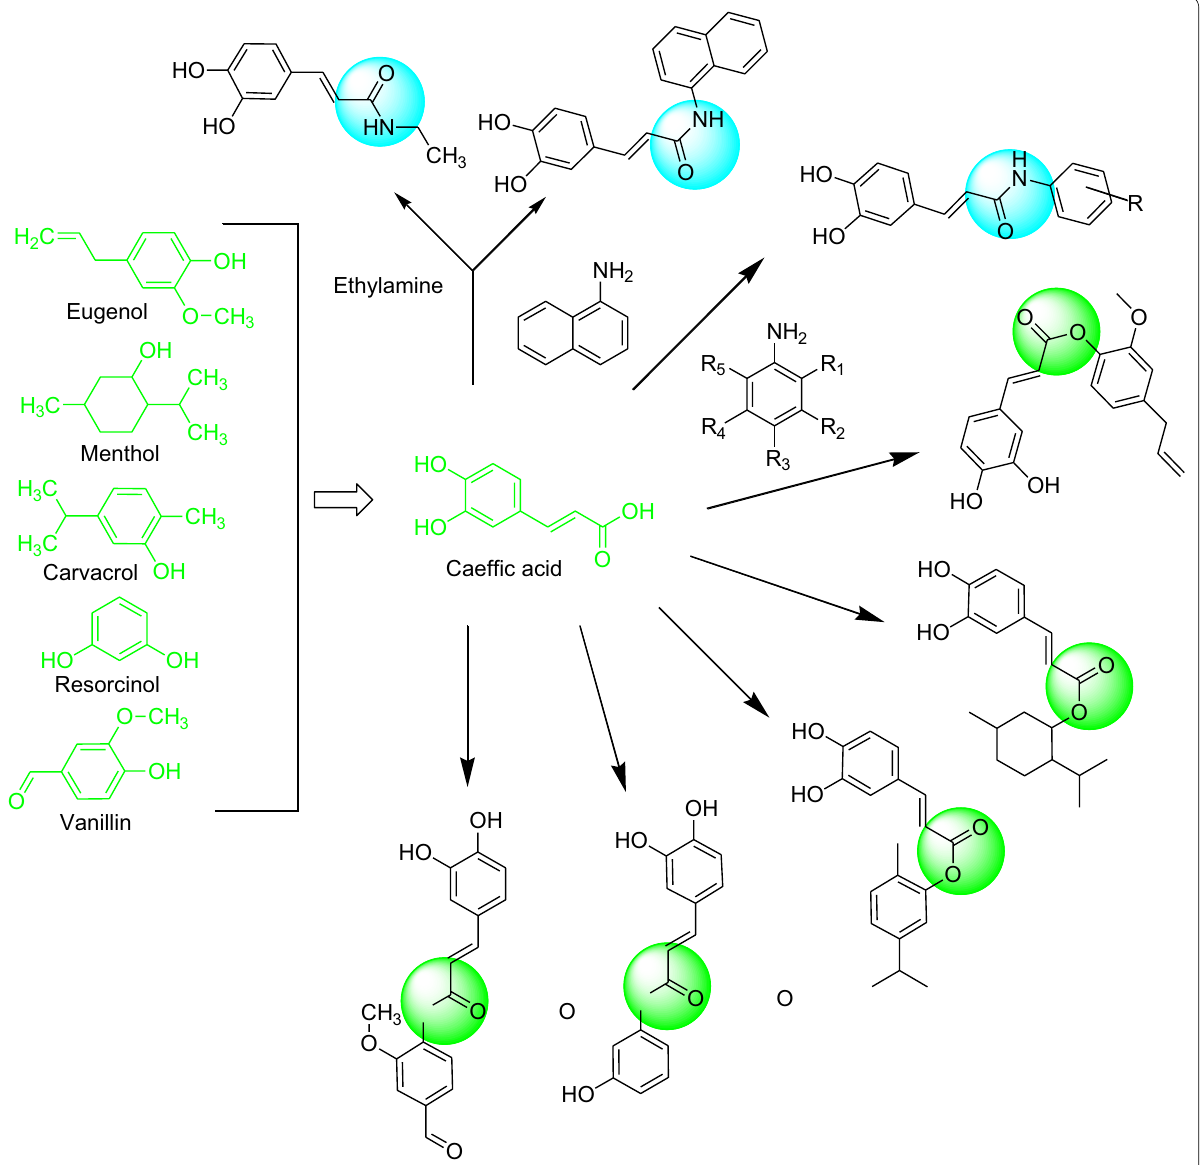
Fig. 2 Design of strategy caffeic acid derivatives for anti-MAO and antioxidant